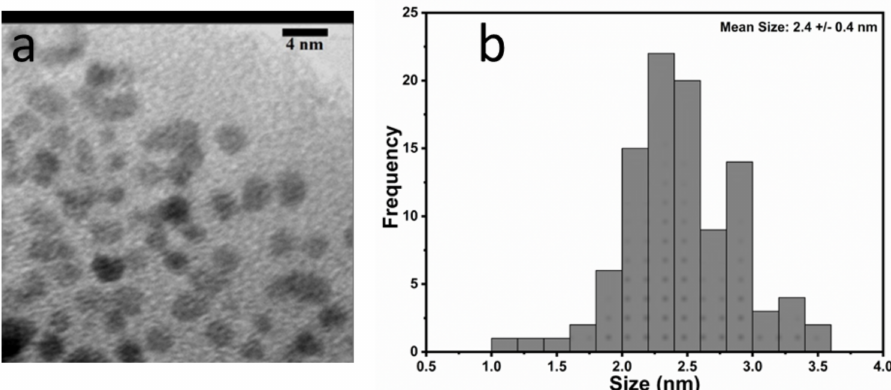
Figure 1. ( a ) BF-TEM micrograph and ( b ) the statistical size distribution of a typical population of NSCDs.